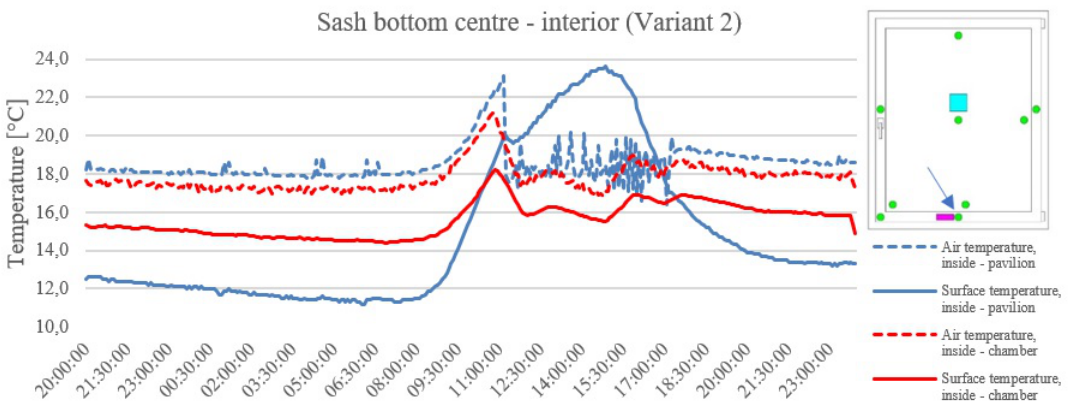
Figure 6. Temperature courses for the bottom of windows sash. Difference of about 3 °C in surface temperatures.